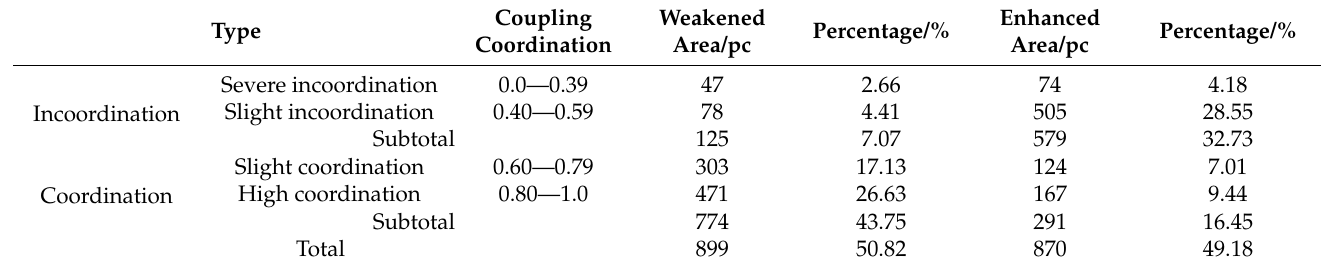
Table 4. The results of the degree of coupling